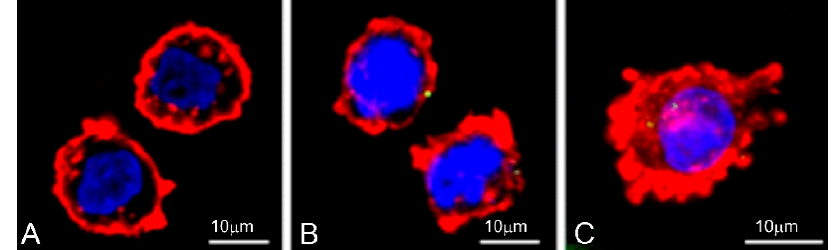
Figure 9. Confocal microscopy images of HL-60 cells after 24 h incubation with ruthenium terminated carbosilane dendrimer with FITC (CRD13-FITC). A-control, B-2.5 µmol/L and C-5 µmol/L. Bar = 10 µm.